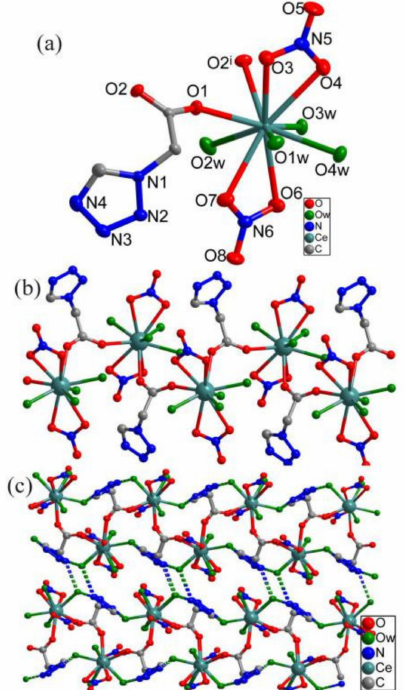
Figure 2. ( a ) The coordination environment of Ce with 50% ellipsoids; ( b ) one-dimensional chain with left-handed chirality; ( c ) three-dimensional network of 2 formed by O–H ... N hydrogen